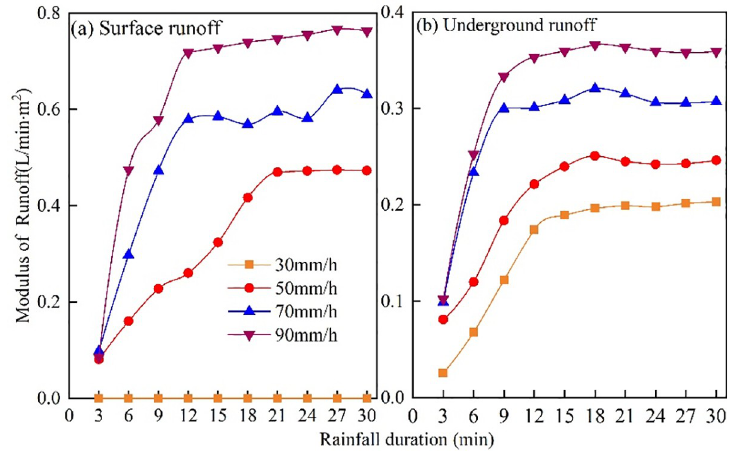
Fig 4. Variation of runoff with rainfall duration under different rainfall conditions.